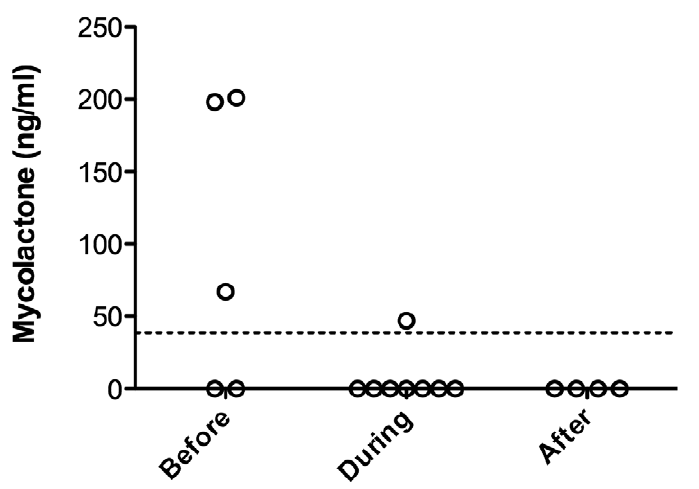
Figure 5. Mycolactone concentration in the serum of BU patients during antibiotic therapy. Mean concentration of mycolactone in serum samples collected before (0 week), during (2 to 8 weeks of treatment), or after completion of the 8 week antibiotic treatment. Dashed horizontal line indicates detection threshold.